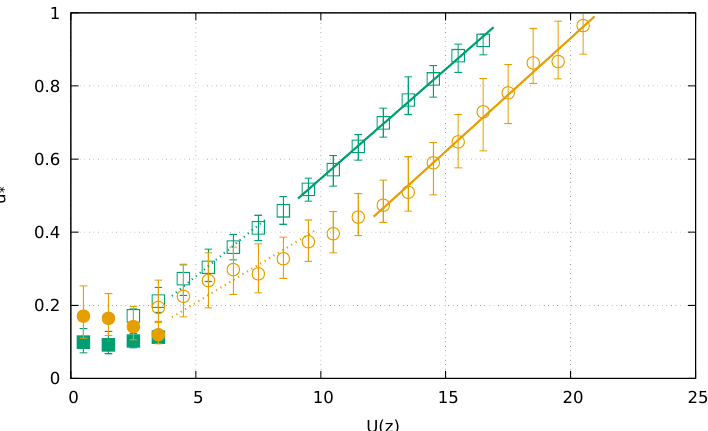
Figure 7. u ∗ ( z ) vs. U ( z ) , for 30 min averaging intervals. Open symbols: near neutral conditions; closed symbols: stable conditions; green: z = 2 m, brown: z = 9 m. Lines from the fits: dotted lines, MOST similarity below the threshold velocity; continuous lines: HOST large wind behavior, beyond the threshold